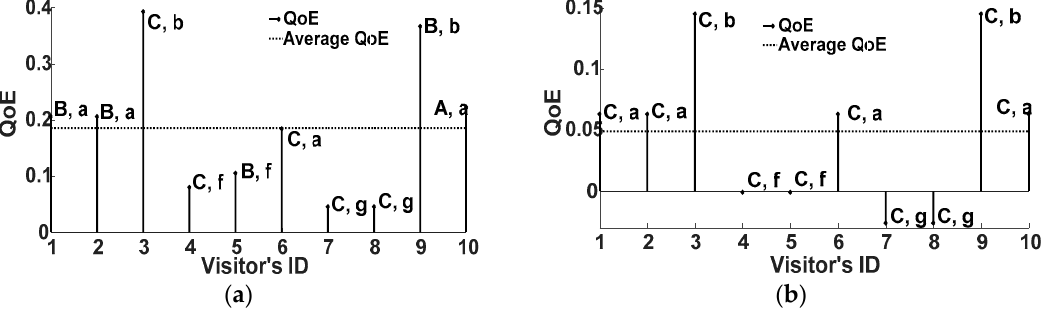
Figure 3. Visitors’ QoE as a function of their ID ( a ) under the RSVTM algorithm and ( b ) assuming that all visitors select the best recommendation (Recommendation C) in terms of potentially achieved QoE.